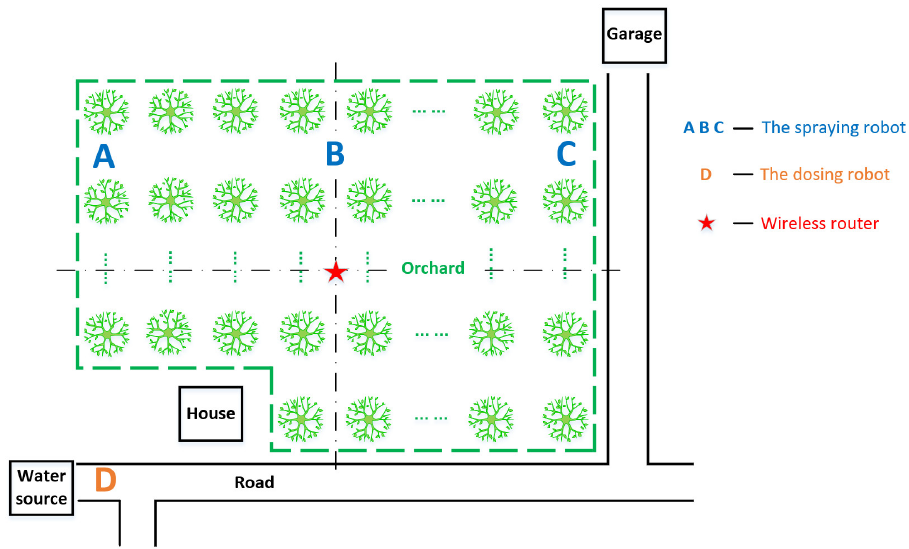
Figure 16. Communication experiment schematic.